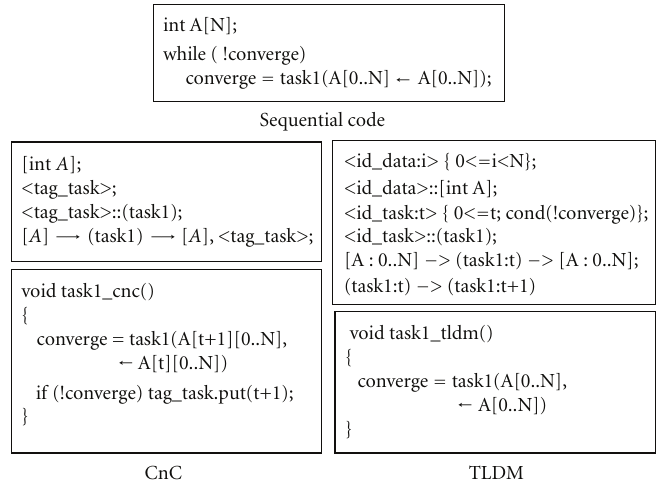
Figure 14: DSA (CnC) versus user-specified dependence